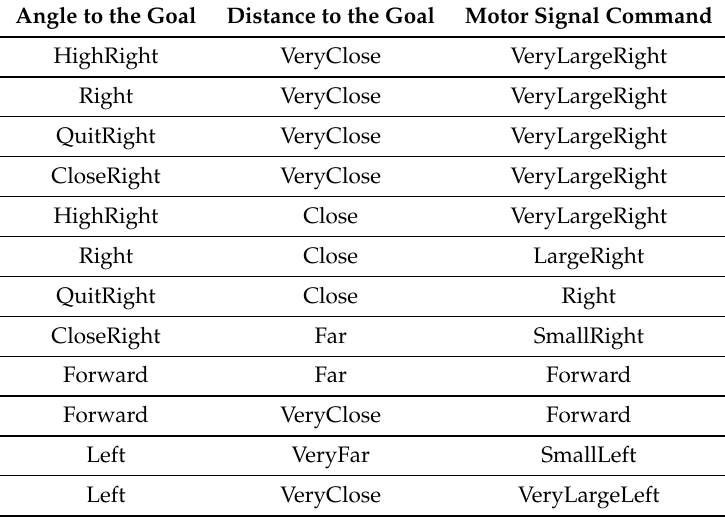
Table 1. Run-To-Goal Controller Fuzzy Rules Sample. Angle to the Goal Distance to the